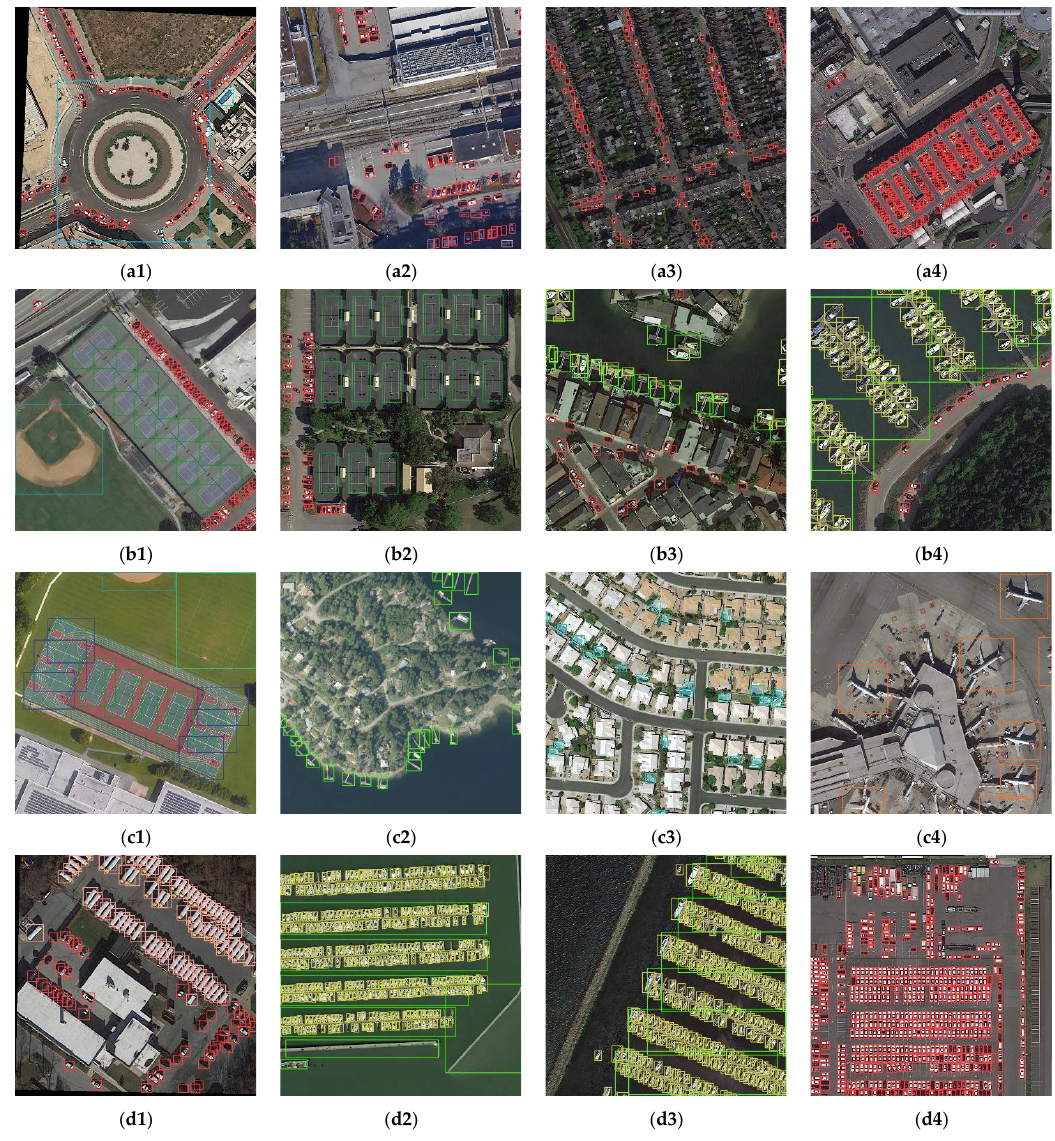
Figure 13. Visualization results in four cases of the DOTA dataset. ( a1 – a4 ) Shows the objects with a small size; ( b1 – b4 ) shows the objects with different sizes in RSIs; ( c1 – c4 ) shows the objects in complex backgrounds; ( d1 – d4 ) shows the objects arranged densely.